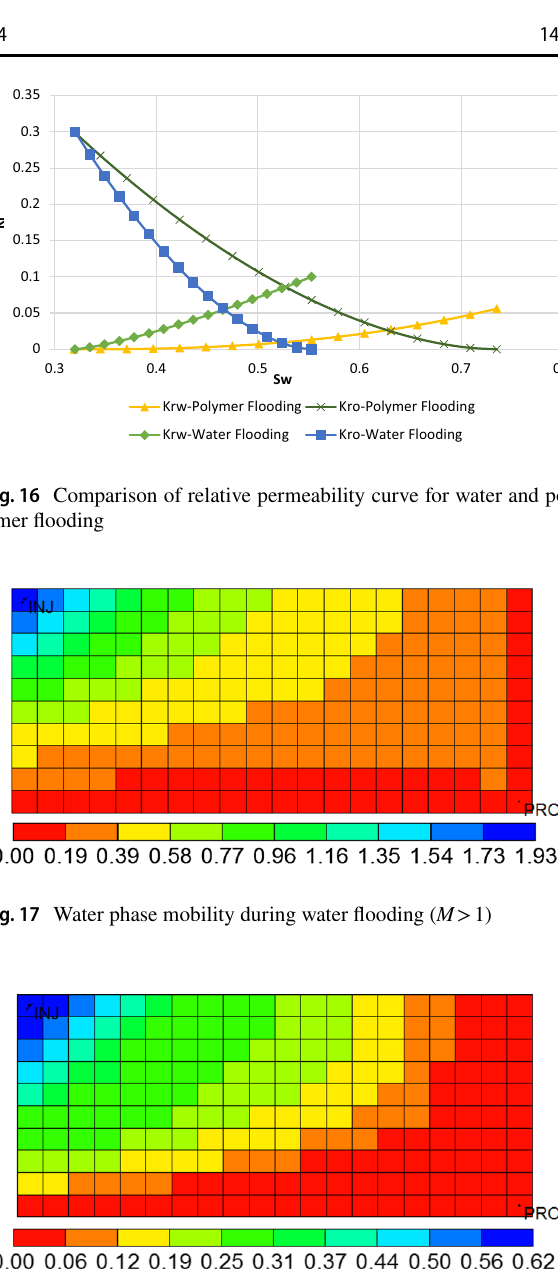
Fig. 18 Water phase mobility during polymer flooding ( M <